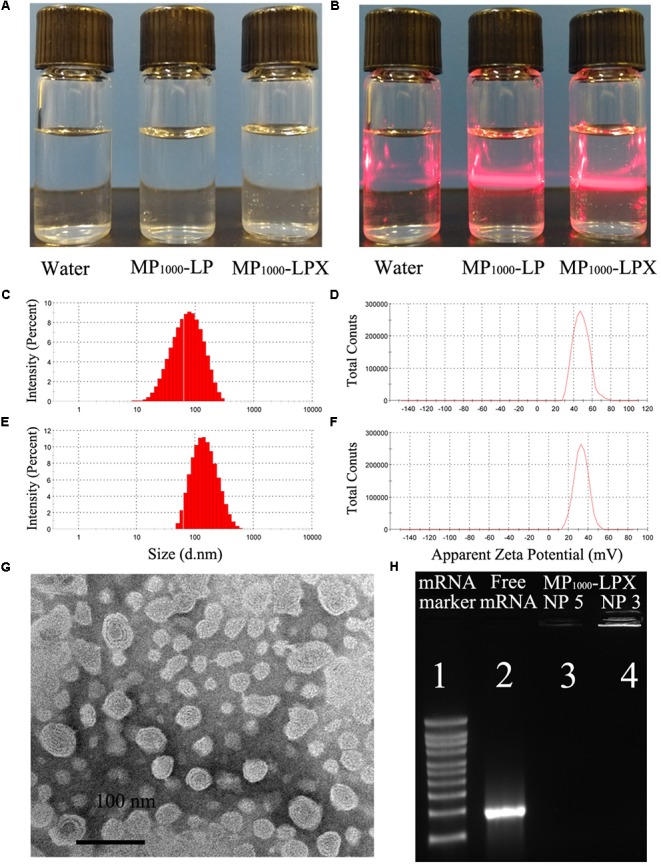
Characterization of MP1000-LPX. Appearance (A) and Tyndall effect (B) of MP1000-LPX. Size (C) and zeta potential (D) of MP1000-LP were recorded by Zetasizer Nano ZS90, and representative images were showed. Representative images of size (E) and zeta potential (F) of MP1000-LPX. (G) TEM images of the MP1000-LPX NP 5. (H) Agarose gel electrophoresis image of mRNA maker, Free mRNA, MP1000-LPX (N/P 5) and MP1000-LPX (N/P 3).